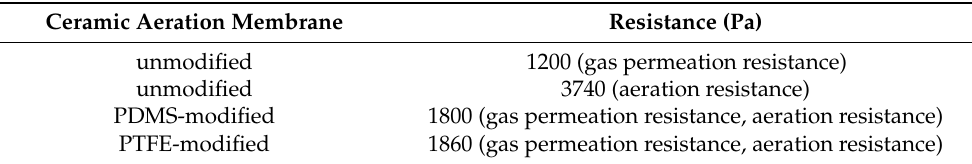
Figure 4. DTG and TG curves of ceramic aeration membranes: ( a ) PDMS-ceramic membrane and ( b ) PTFE-ceramic membrane. Table 2. Resistance variation of ceramic aeration